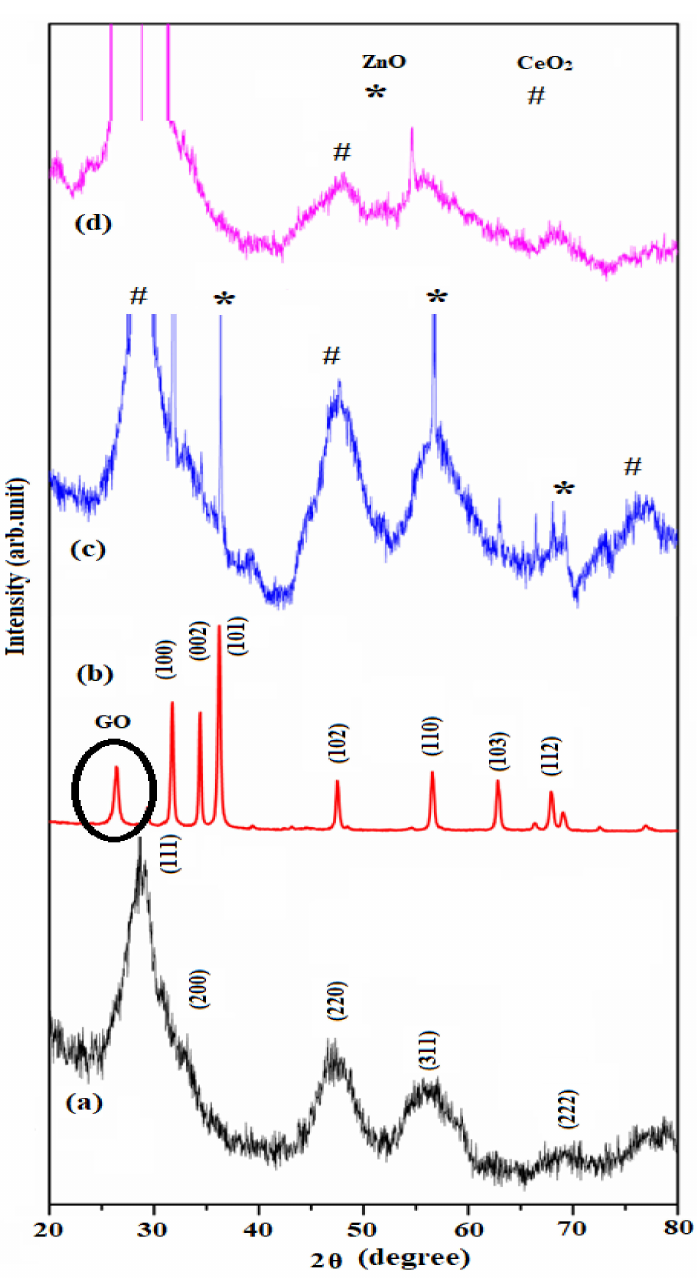
Figure 3. X-ray diffraction analysis of ( a ) CeO 2 , ( b ) GO-ZnO, ( c ) ZnO@CeO 2 and ( d ) GO-ZnO@CeO 2 . It is interesting to note that the X-ray diffraction patterns of ZnO@CeO 2 and GO- ZnO@CeO 2 nanohybrids, revealed in several diffraction planes of the cubic structure of CeO 2 and hexagonal wurtzite structure of ZnO nanoparticles, were confirmed and no characteristic peaks of graphene oxide were detected, indicating the influence of metal oxide nanoparticles. Moreover, XRD analysis reveals a good crystalline phase for ZnO and CeO 2 nanomaterials using the hydrothermal method, which is reliable through TEM analysis